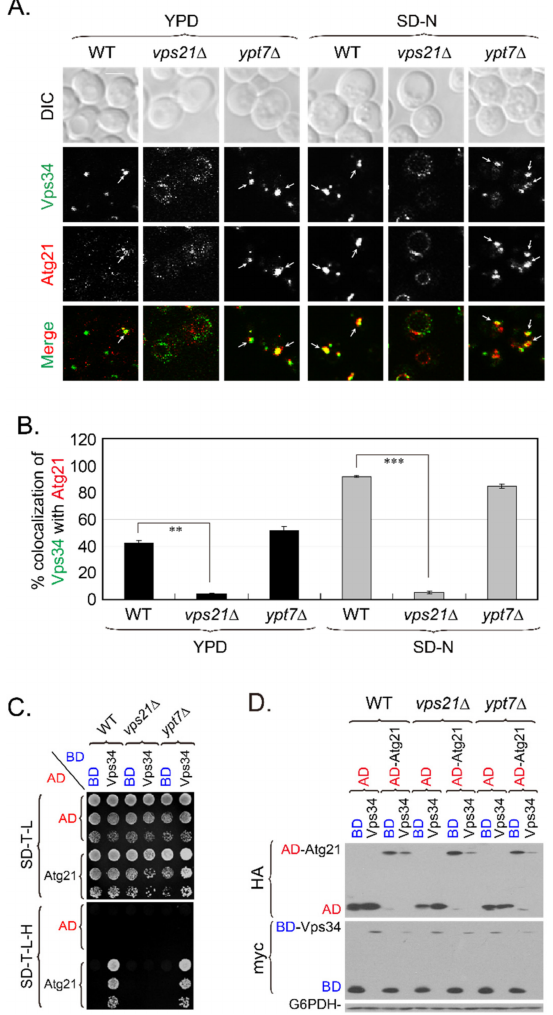
Figure 2. Vps34 interacts with Atg21 in a Vps21-dependent manner. ( A ) The colocalization between Vps34 and Atg21 depended on Vps21 but not on Ypt7. VPS21 or YPT7 was deleted from the Vps34- mNeonGreen and Atg21-tdTomato tagged strains. The indicated strains were grown in YPD medium, or further grown in SD-N medium for 2 h for fluorescence determinations. The arrows indicate colocalizing puncta; scale bar, 2 µ m. ( B ) Quantification of the Vps34-Atg21 colocalization shown in panel ( A ). The percentage of colocalizing dots (based on Atg21-positive dots) was quantified from at least 70 red dots in two independent experiments and is expressed as the mean ± SD. **, p < 0.01; ***, p < 0.001. ( C ) The Vps34-Atg21 interaction depended on Vps21 but not on Ypt7, as determined by Y2H assays. The interactions were determined in WT, vps21 ∆ , and ypt7 ∆ cells. ( D ) Immunoblotting analysis indicated that Vps34 and Atg21 were expressed at similar levels in vps21 ∆ cells as in WT and ypt7 ∆ cells. The diploid cells shown in panel ( C ) (grown on SD-T-L plates) were analyzed for protein expression as in Figure 1B. G6PDH served as a loading